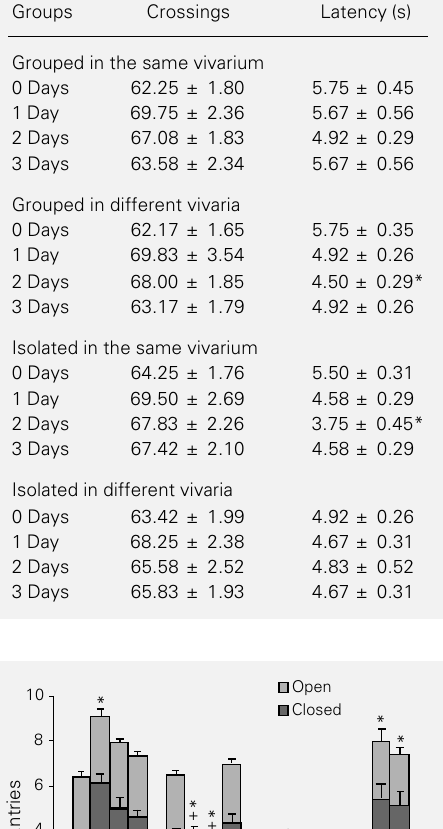
Figure 1 - Total number (mean ± SEM) of entries into both arms. The rats were ex- posed to novelty for 0, 1, 2 or 3 days. GS, Rats grouped in the same vivarium; GD, rats grouped in different vivaria; IS, rats isolated in the same vivarium, and ID, rats isolated in different vivaria. *P<0.05 compared to the correspond- ing 0-day exposure group; + P<0.05 compared to